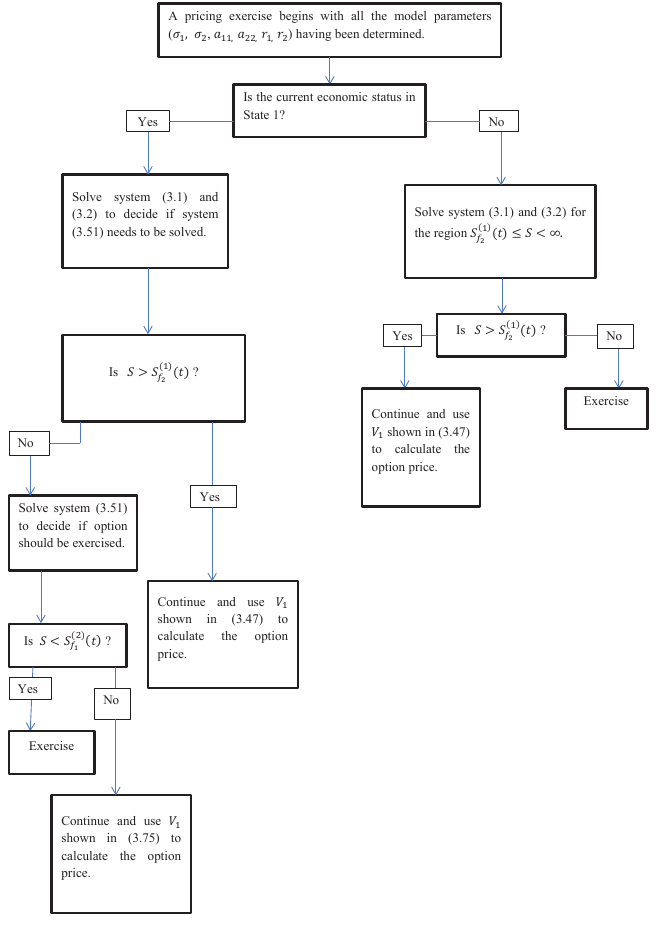
Figure 1. An illustrative flow chart for the usage of our